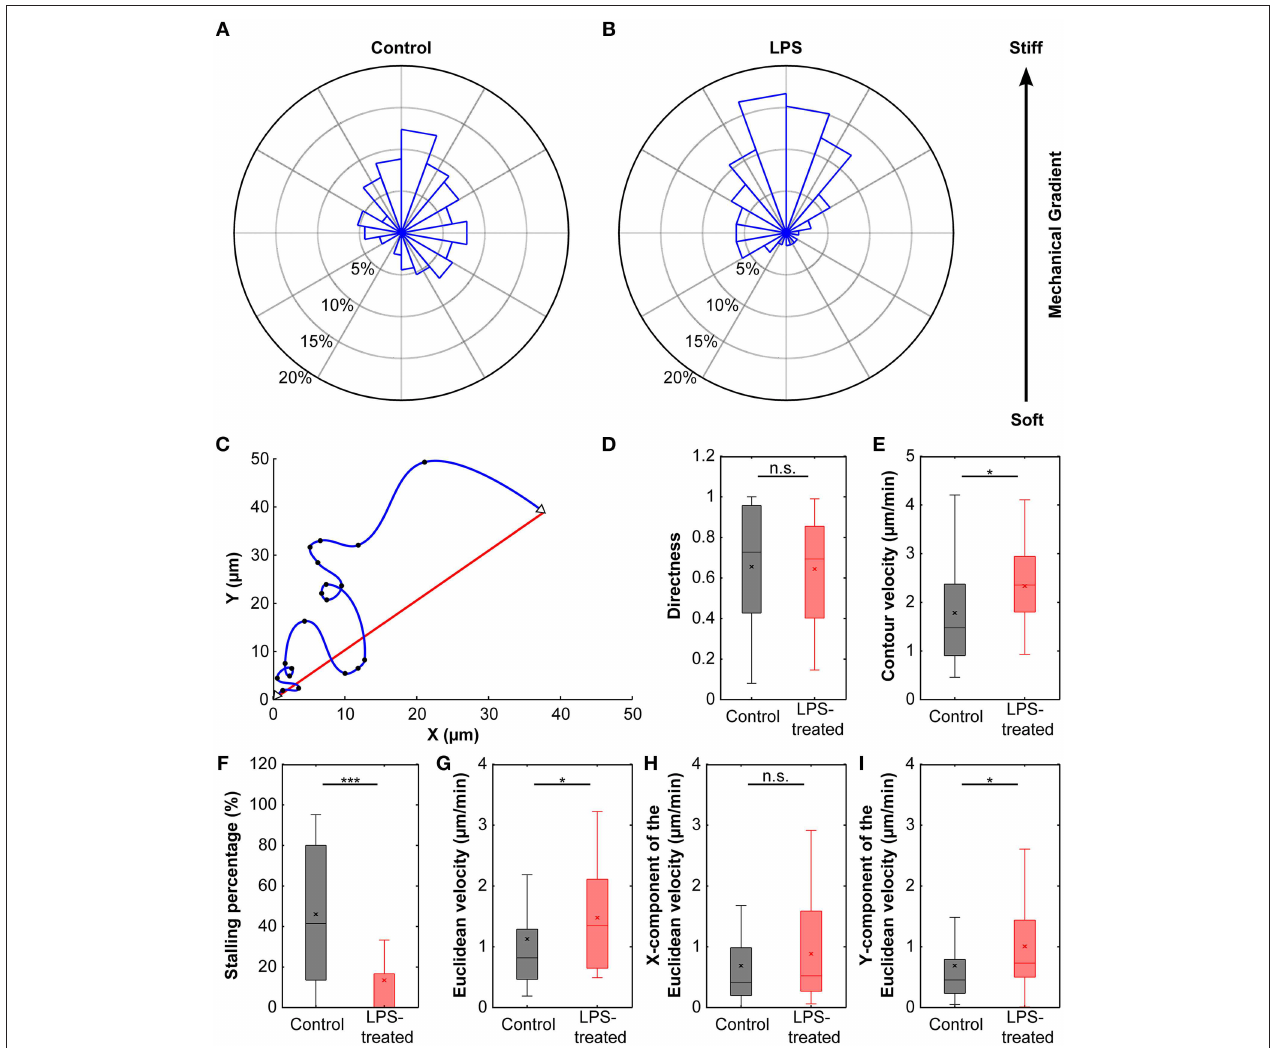
FIGURE 6 | Durotaxis of microglial cells. (A) Distribution of microglial cell positions at the end of an experiment. Cells were cultured on compliant substrates ( ∼ 5 kPa) incorporating a stiffness gradient of ∼ 8 Pa/ µ m and preferentially migrated toward the stiffer side of the substrate ( N = 38 ). (B) After activation with LPS, microglia durotaxis was significantly enhanced ( N = 22 ). Rose plots were obtained from binned endpoints (bin size: of 60 ◦ , with 20 ◦ overlap). (C) Schematic plot of microglia migration. Start and end positions are marked with open triangles; black dots indicate cell positions recorded during time-lapse imaging. The blue curve shows the actual migration path (“contour”), the red line indicates the Euclidean distance between start and end position. (D) The directness D was similar for control and LPS-treated cells ( p > 0 . 7 , Mann-Whitney U -test). (E,G) Contour velocity v c and Euclidean velocity v e significantly increased after application of LPS ( p < 0 . 05 , Mann-Whitney U -test). (F) Stalling phases were highly reduced after LPS treatment ( p < 10 − 4 , Mann-Whitney U -test). (H,I) While the component of the Euclidean velocity perpendicular to the mechanical gradient (x-component) was similar for control and LPS-treated cells ( p > 0 . 2 , Mann-Whitney U -test), the component